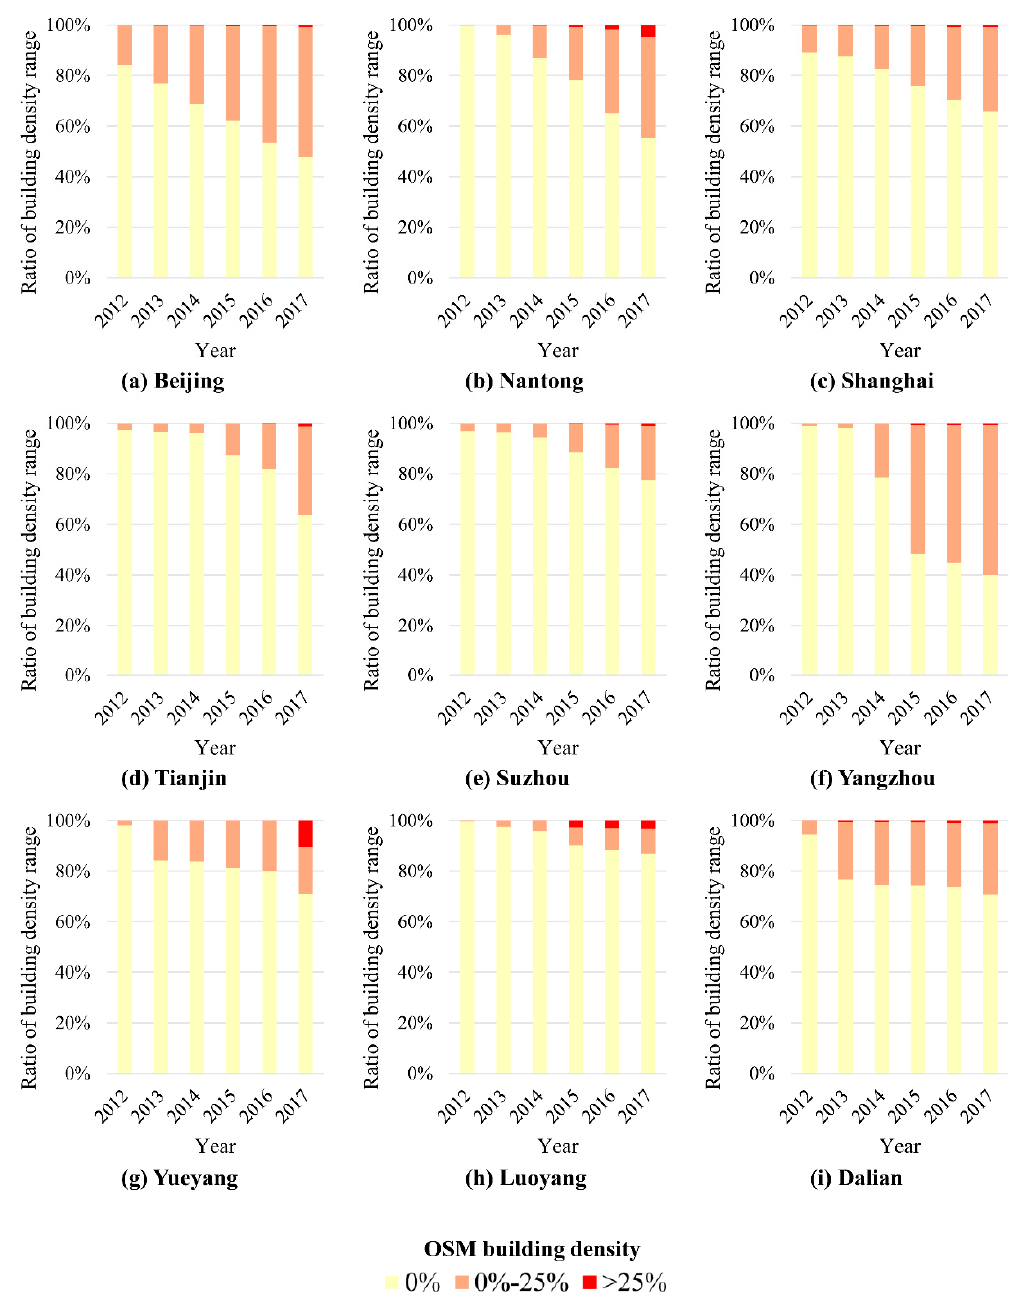
Figure 6. ( a – i )Variation of OSM building density from 2012 to 2017, for nine prefecture-level